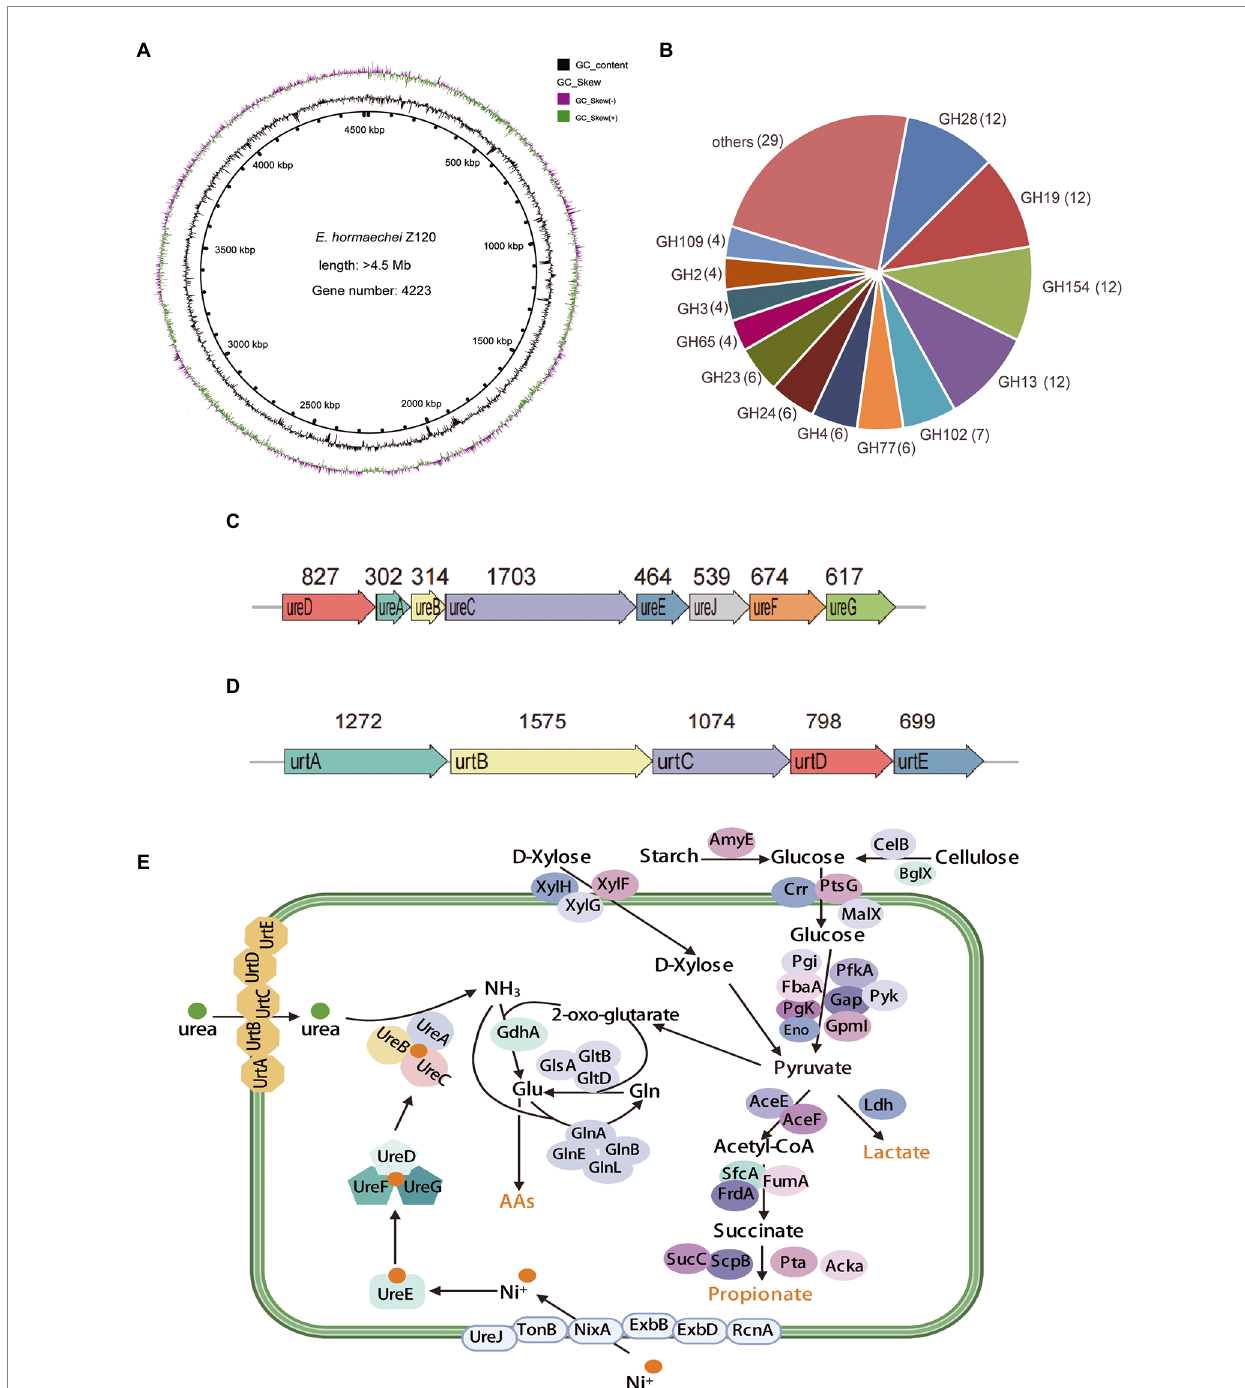
FIGURE 2 Functional genes related to urea and carbohydrate metabolism of strain Z129. (A) Circle diagram showing the genome. From the outside to the inside are GC-skew and GC-content. (B) The number of annotated genes in different GH families. The GH families with less than four genes were combined into the others. (C) Gene clusters for urea hydrolysis. The number indicates the length of the gene, the unit is bp. (D) Gene clusters for urea transportation. The number indicates the length of the gene, the unit is bp. (E) Genes involved in urea transport, nickel ions transport, urea hydrolysis, ammonia assimilation, starch metabolism, cellulose metabolism, xylose metabolism, and pyruvate